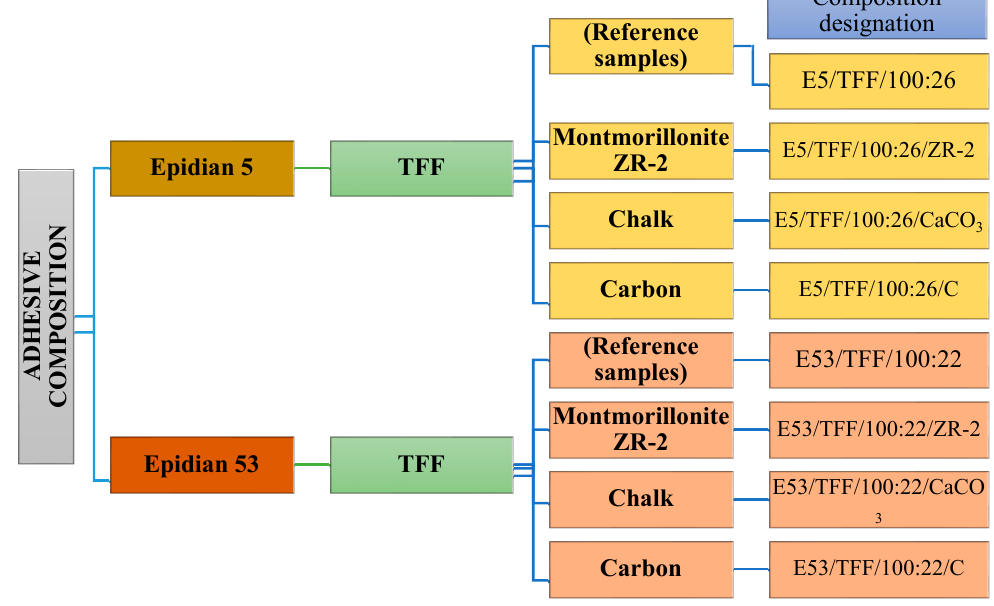
Figure 2. Scheme of the adhesive compositions’ ingredients used in the study and their designations.